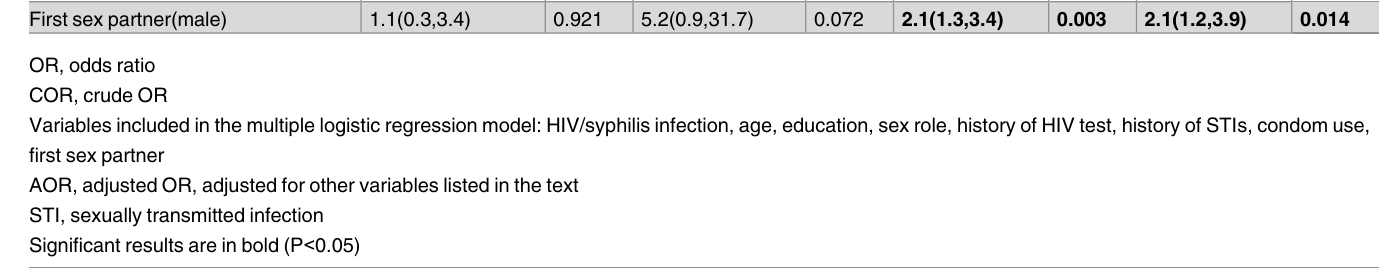
(OR = 0.4; 95%CI: 0.2–0.6) and elder in age ( > 30) (OR = 0.6; 95%CI: 0.4–0.9) were negatively associated with HIV infection.